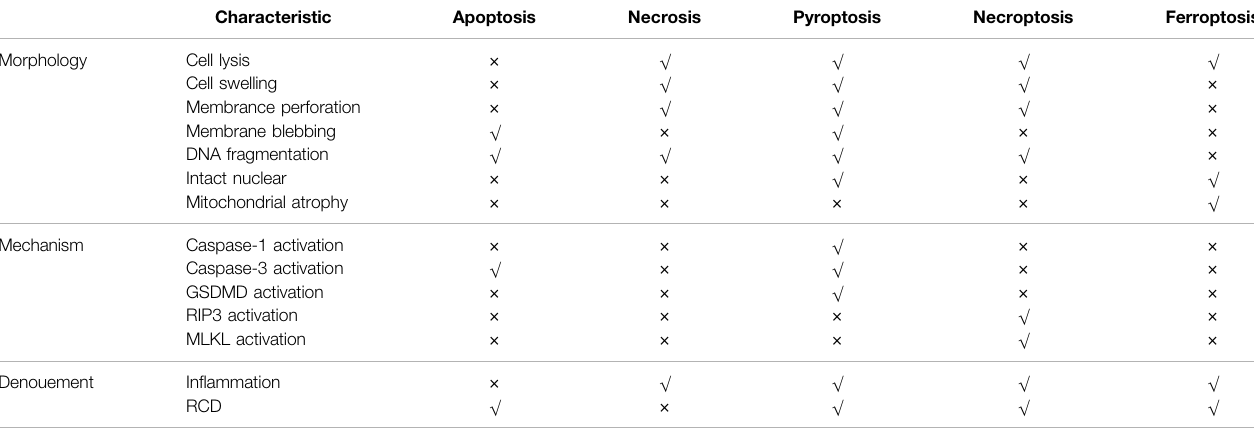
TABLE 1 | Difference among of the fi ve forms of cell death.